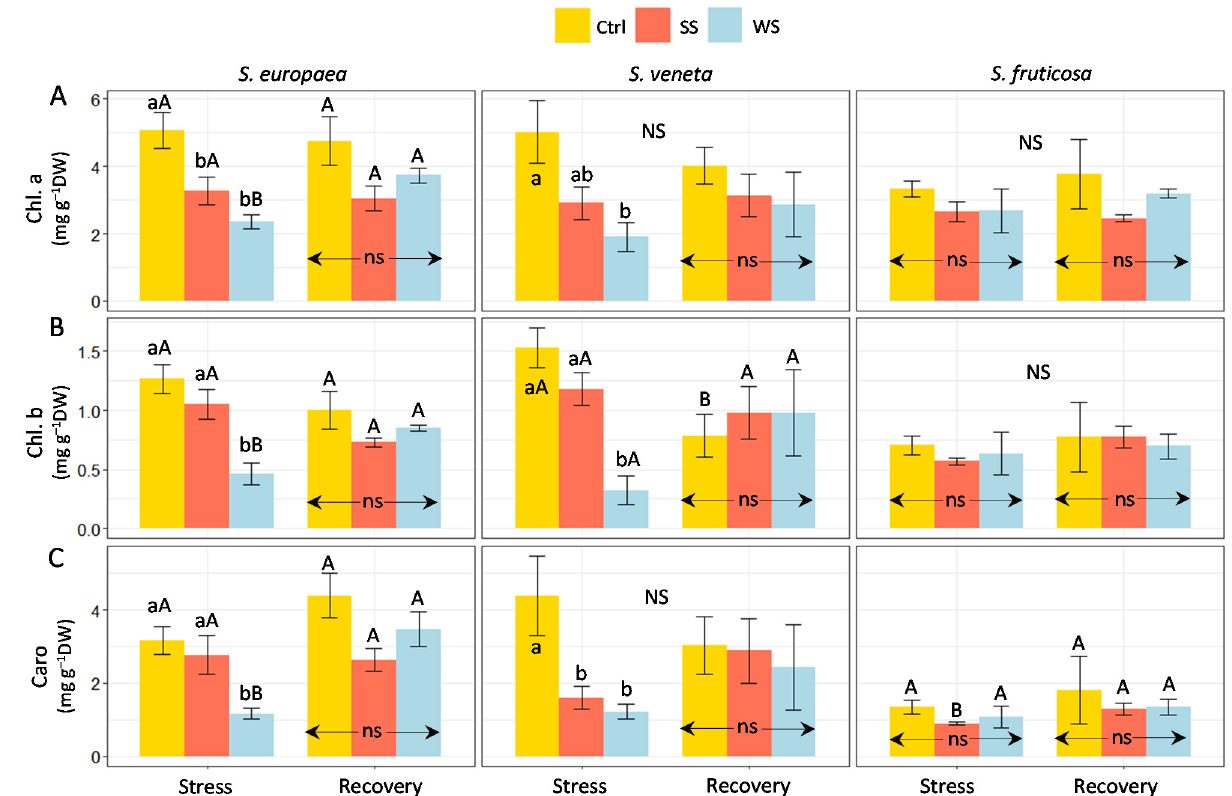
Figure 3. Effect of 30 days of stress treatments (Stress), followed by watering with non-saline water for 15 days (Recovery) on ( A ) chlorophyll a (Chl. a), ( B ) chlorophyll b (Chl. b), and ( C ) carotenoids (Caro) in the three halophytes. Ctrl, control; SS, salt stress (watering with 700 mM NaCl); WS, water stress (complete withholding of irrigation). For each species and sampling (Stress or Recovery), different lowercase letters over the bars indicate significant differences between treatments (Ctrl, SS, and WS), at p ≤ 0.05; ns: non-significant. Different uppercase letters indicate significant differences between the two samplings (Stress and Recovery) for each species and treatment, at p ≤ 0.05; NS: non-significant. Vertical bars indicate standard error ( n = 4).